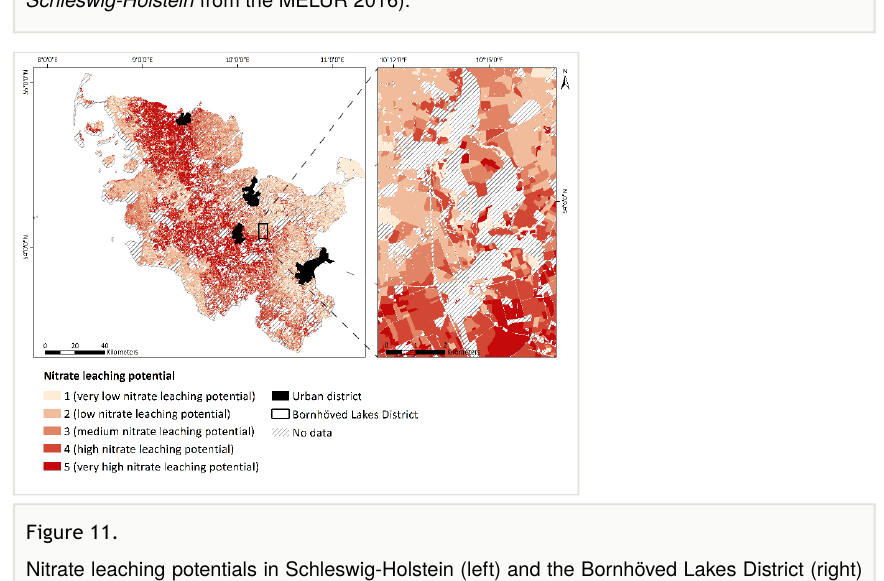
Figure 10. Interpolated groundwater nitrate concentration in Schleswig-Holstein (left) and the Bornhöved Lakes District (right) in 2013 (data from W asserkörper- und Nährsto ffi nformationssystem Schleswig-Holstein from the MELUR 2016).